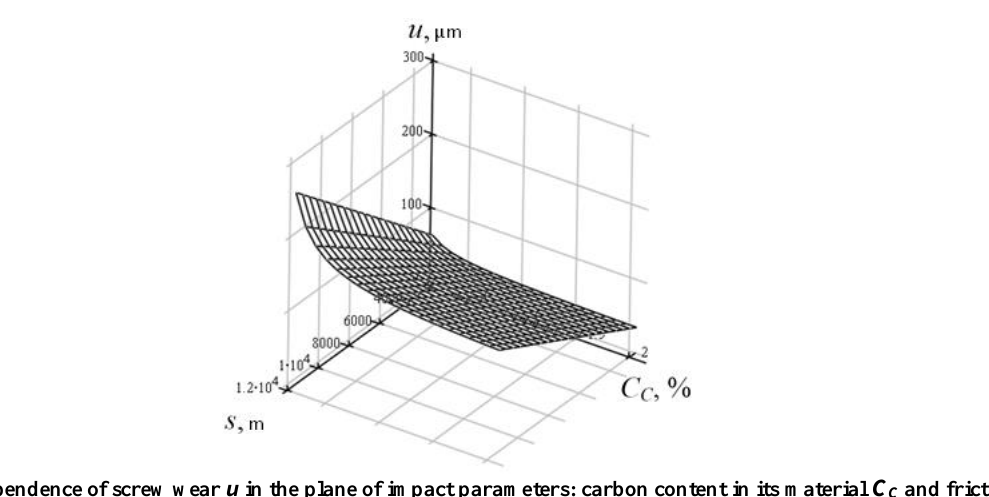
Fig. 3. Dependence of screw wear u in the plane of impact parameters: carbon content in its material C C and friction path s